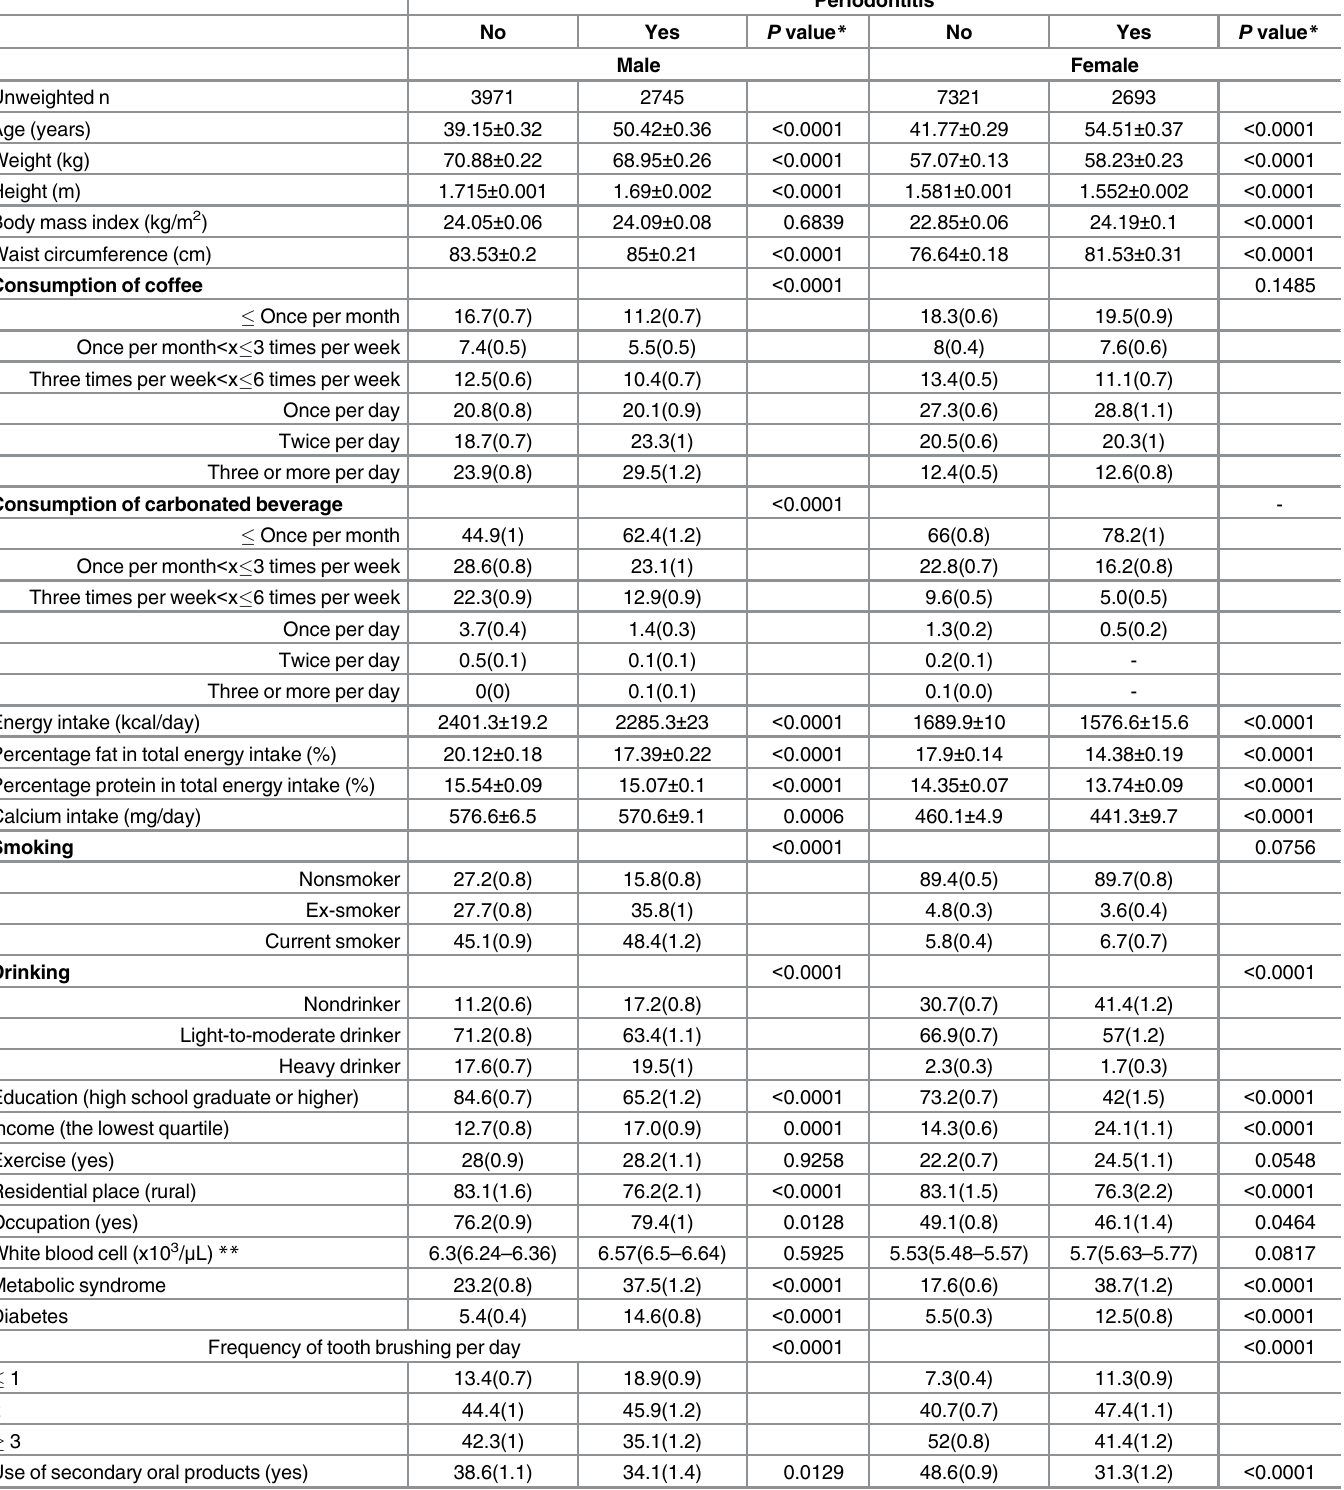
Table 1. Baseline characteristics of study individuals according to periodontal